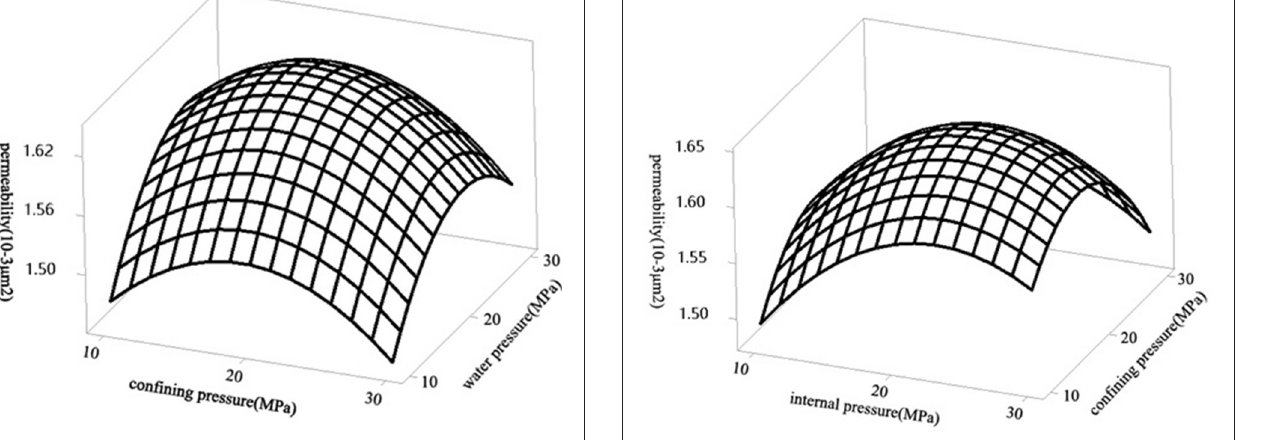
FIGURE 6 | Surface of permeability (10 − 3 µ m 2 ) vs. water pressure and confining pressure.